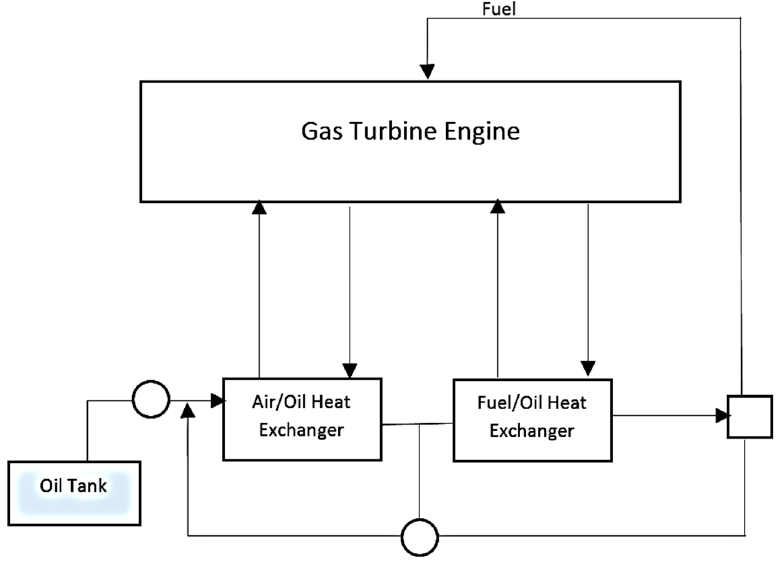
Figure 1. Thermal management system embodiments proposed by United Technologies Corporation.